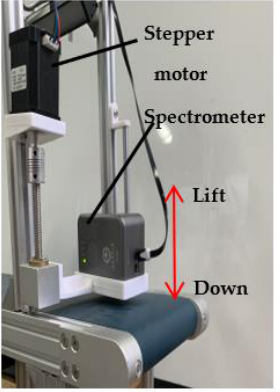
Figure 4. Design of spectral data acquisition platform.